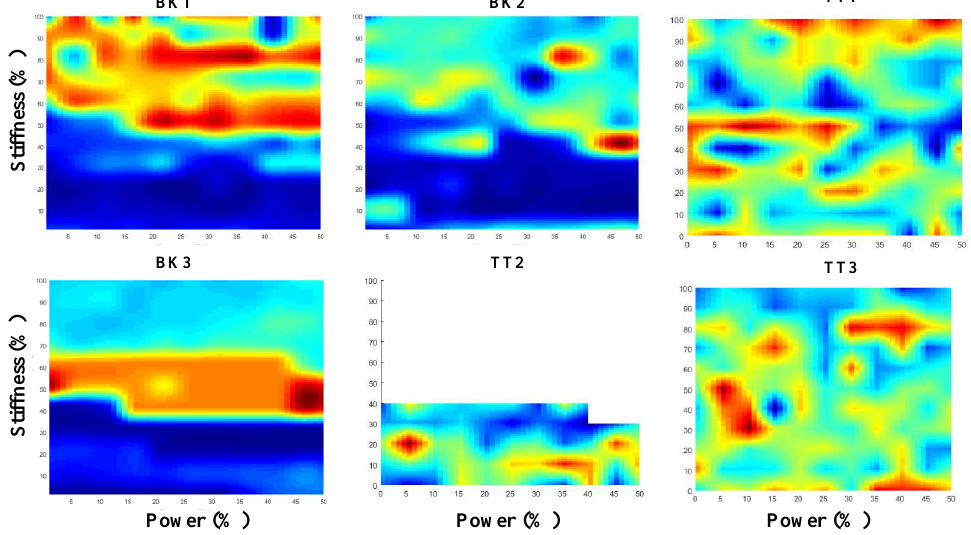
Figure 4. Grids of the modeled muscular activity using 10-channel electromyogram (EMG) sensor for various combinations of the stiffness and power parameters for three bent-knee and three trasfemoral amputee subjects.